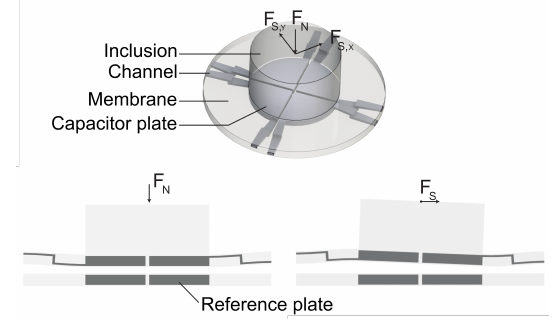
Figure 7. Design of a 3DOF force sensor with infused conductors.